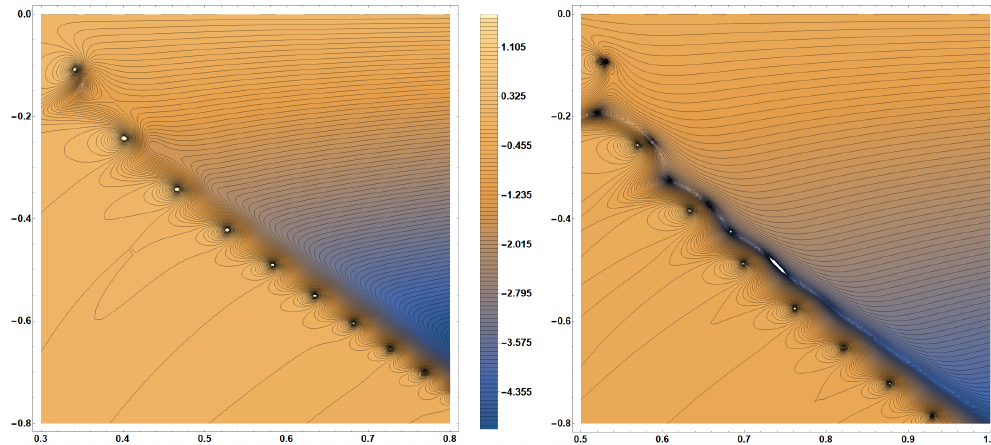
Figure 3 . The two plots are contour plots of the logarithm of the absolute value of the S-matrix from eq. (5.7). The plot is in the lower half complex ω plane (in Planck units) and the vertical axis parametrises = ω while the horizontal < ω . In the left figure l = 1 , while in the right l = 2 . We find a series of resonances where the contours accumulate (dots). These resonances are what replaces the usual quasinormal modes of the black hole as described in the main text of subsection 5.2. We also observe a deep trough where the S-matrix goes close to zero near the location of the poles, that becomes deeper and narrower for higher harmonics (blue region of the plot). These frequencies correspond to approximately trapped modes in the near horizon